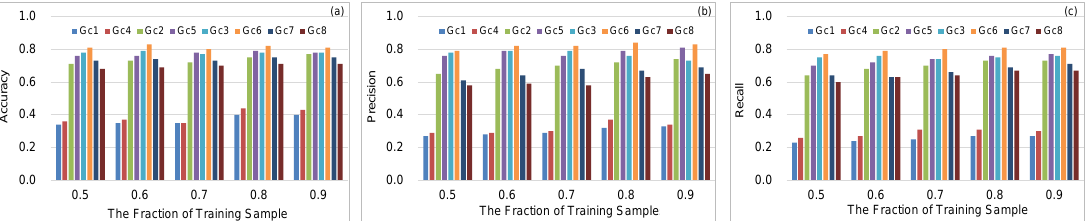
Figure 2. The performance of bimodal data based eight experimental groups. ( a ) The accuracy of bimodal emotion classification on eight experimental groups. ( b ) The precision of bimodal emotion classification on eight experimental groups. ( c ) The recall of bimodal emotion classification on eight experimental groups. Table 4. Average performance of bimodal data based experimental groups. Accuracy Precision Group